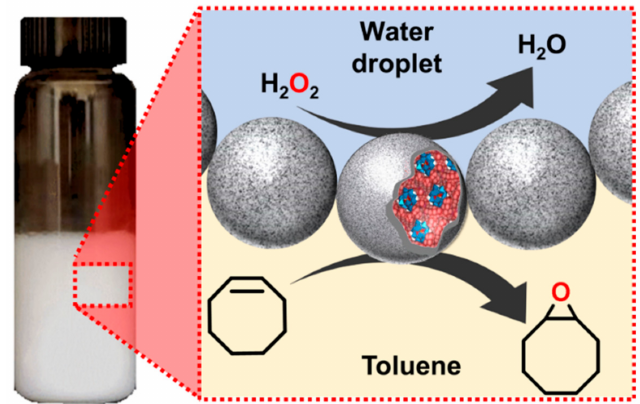
Figure 60. A schematic representation of cyclooctene epoxidation in a water-in-toluene Pickering emulsion stabilized with an amphiphilic dodecyltrimethylammonium/PW 12 O 40 NP